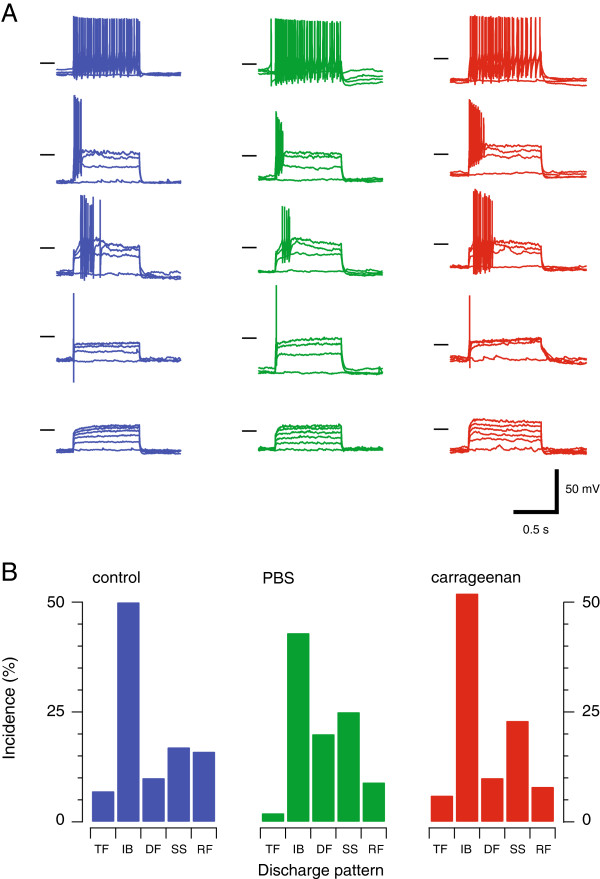
Acute neck muscle inflammation does not alter action potential discharge properties. A. Dorsal horn neurons can be classified by the temporal features of their action potential discharge. We have previously described five AP discharge patterns under in vitro [16] and in vivo conditions [15], and also across the lumbar, thoracic and cervical spinal cord in adult mice [17]. Traces show representative examples of each AP discharge pattern (Tonic Firing - TF, Initial Bursting - IB, Delayed Firing - DF, Single Spiking - SS, and Reluctant Firing RF) recorded from control (left), sham (middle), and carrageenan-injected animals (right). Horizontal bars denote −50 mV membrane potential. B. The incidence of the five AP discharge patterns was similar in control, sham, and carrageenan-injected animals.